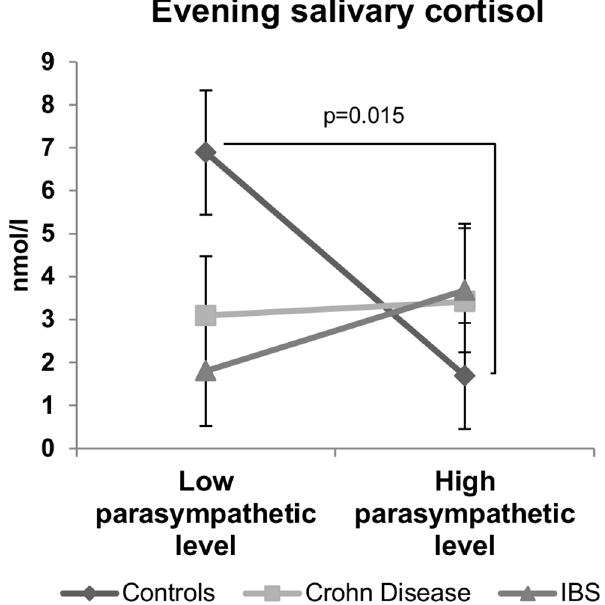
Figure 2. Relationship between the resting parasympathetic vagal tone and the evening salivary cortisol in controls, Crohn’s disease (CD) and Irritable bowel syndrome (IBS) patients. A balance was observed between the parasympathetic tone and the evening salivary cortisol in healthy subjects (control group) but not in CD and IBS patients. Data are expressed as mean 6 sem. Comparisons are made between the high and low parasympathetic level subgroups using permutations test.